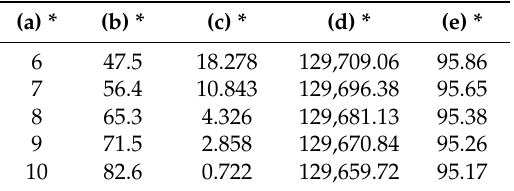
Table 3. Results of using the RSONP algorithm to solve the RSONP problem on the IEEE 118-bus system in Case